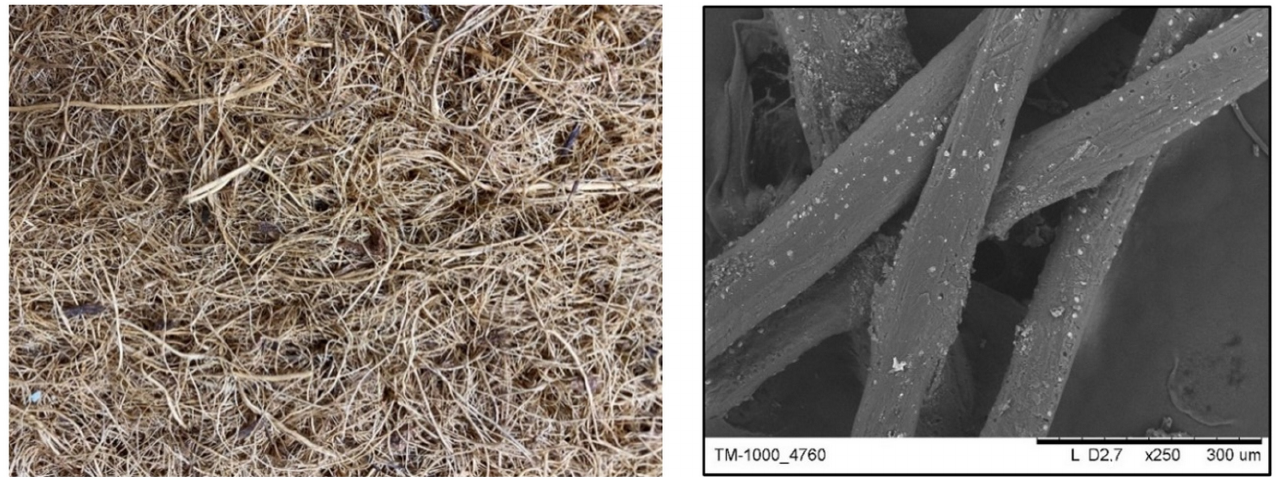
Figure 1. Support coconut mat for PLA fibers.